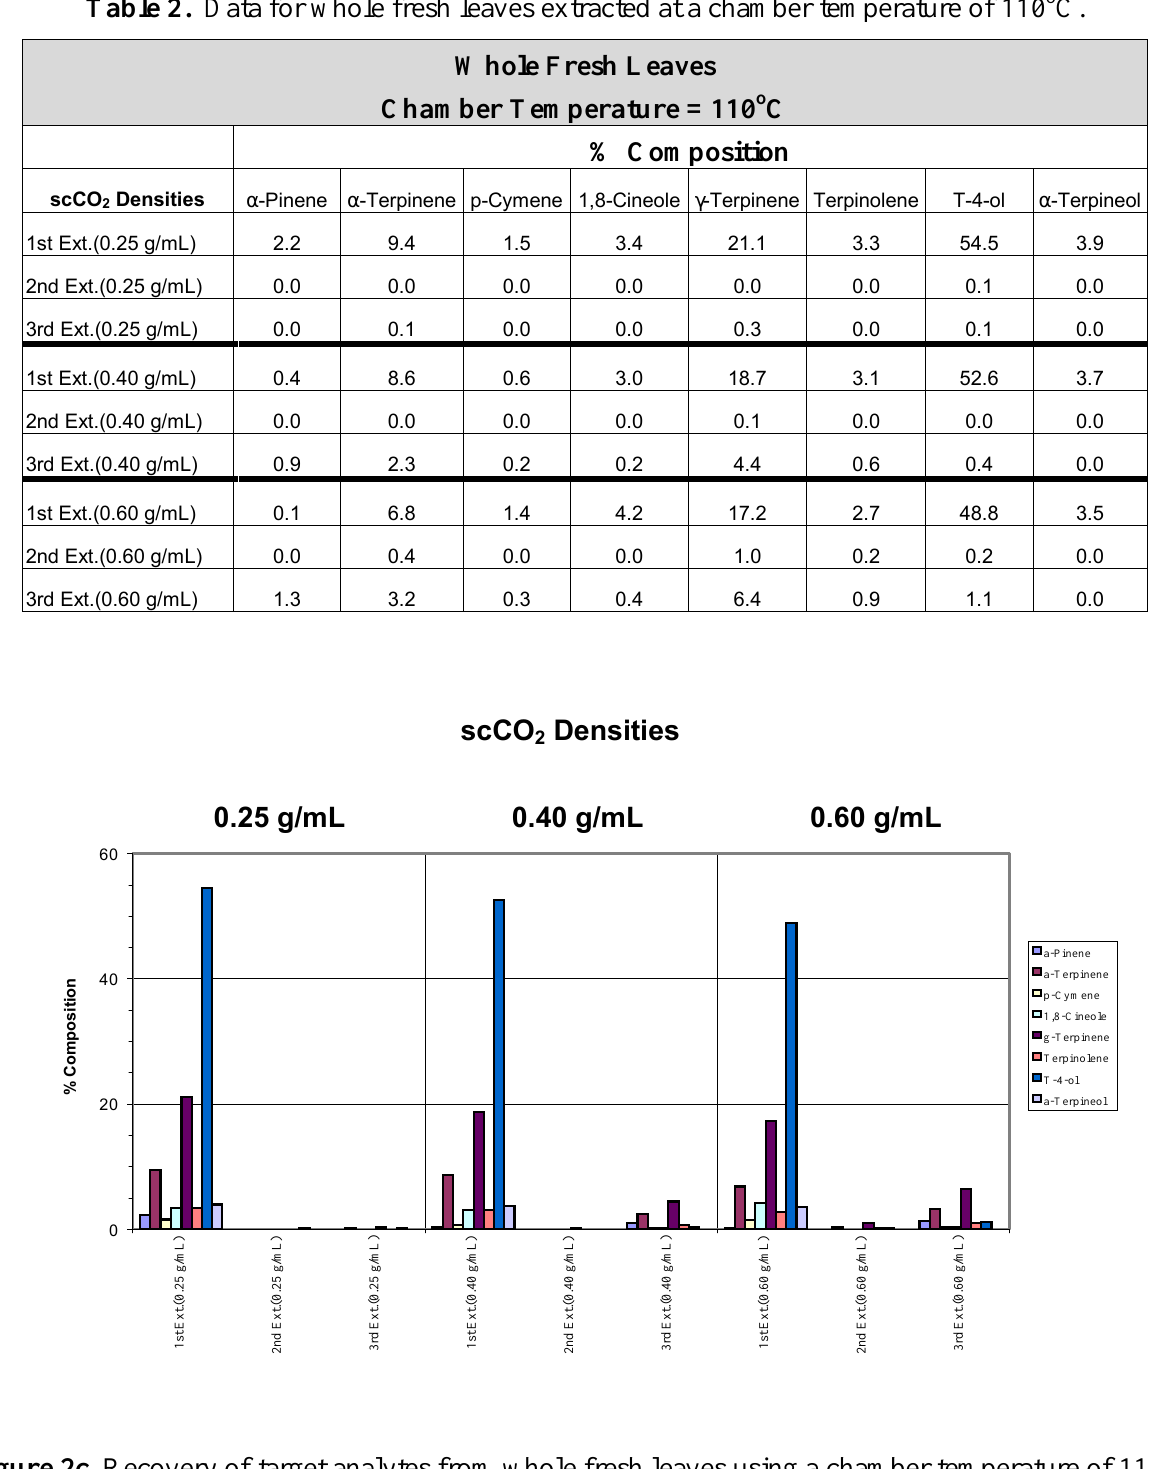
Figure 2c . Recovery of target analytes from whole fresh leaves using a chamber temperature of 110 o